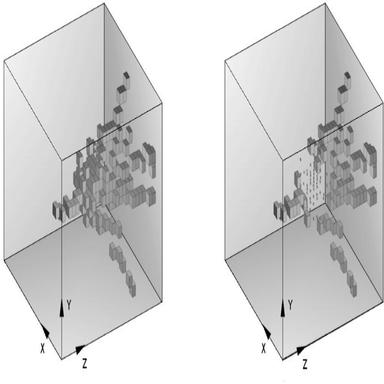
Event display of a −-meson interaction with an energy of 10 GeV (a) before and (b) after removal of the interaction region. Smaller cubes are pads that are part of the interaction region and are not processed by the track-finding algorithm. In this event the hits in the first ten layers are classified as hits left by the incoming −-meson.